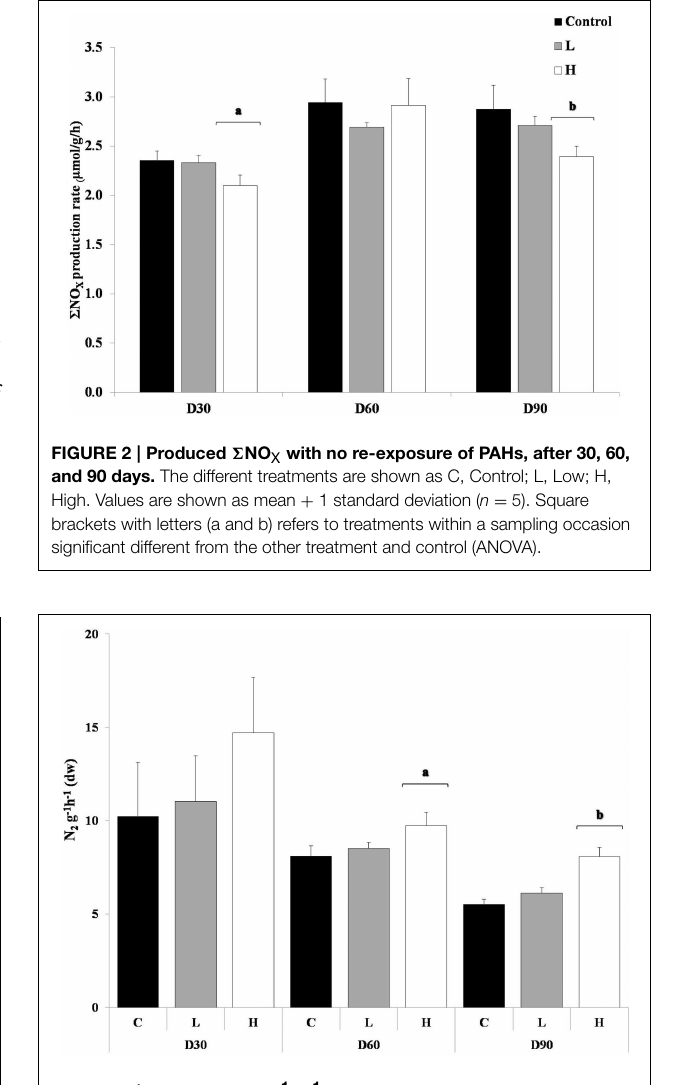
FIGURE 3 | Produced N 2 g − 1 h − 1 (dw) with no re-exposure of PAHs, after 30, 60, and 90 days. The different treatments are shown as C, Control; L, Low; H, High. Values are shown as mean + 1 standard deviation ( n = 5 ). Square brackets with letters (a and b) refers to treatments within a sampling occasion significant different from the other treatments